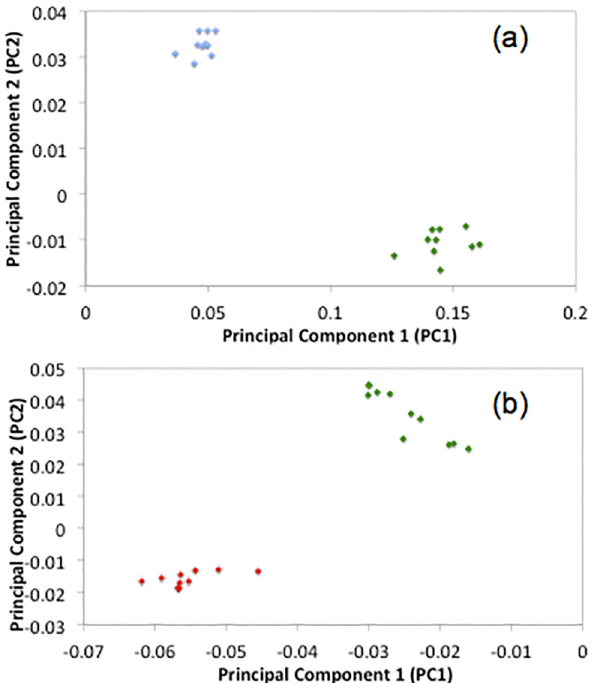
Fig 4. PCA scatter plot of, PC2 vs. PC1, for analysis of (a) paper and paracetamol (blue) vs. the paper device (green) only and (b) paper and ibuprofen (red) vs. paper device